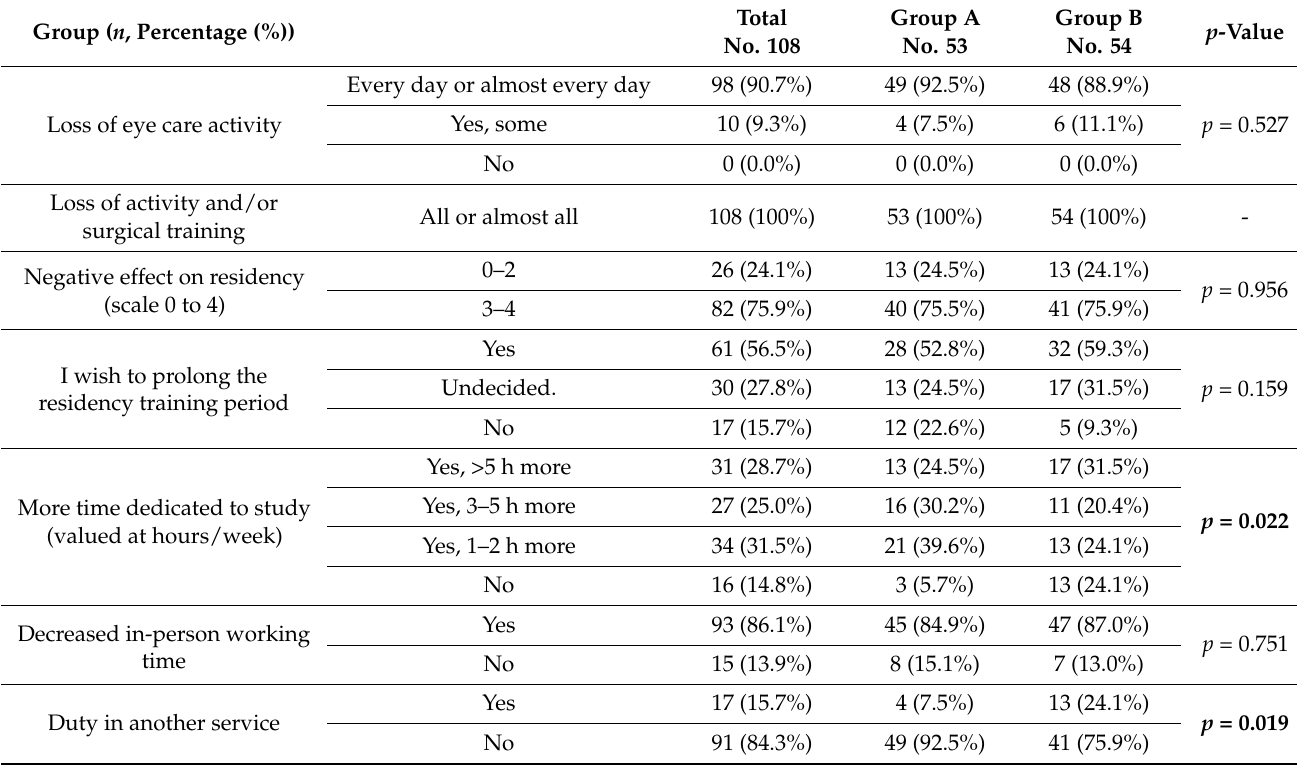
Table 4. Impact of COVID-19 on resident